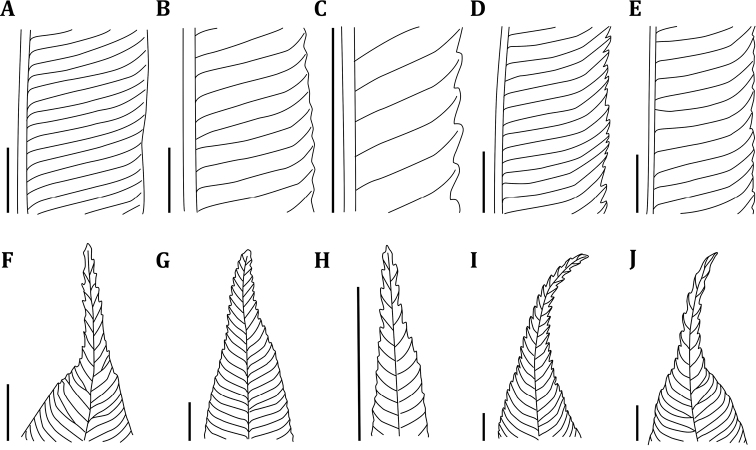
Comparison of venation and margins (A–E) and apices of ultimate segments (F, G) of the Ptisana species in the Solomon Islands A, FP.
ambulansB, GP.
decipiens
var.
decipiensC, HP.
decipiens
var.
delicataD, IP.
papuanaE, JP.
smithii. Scale bars: 5 mm.